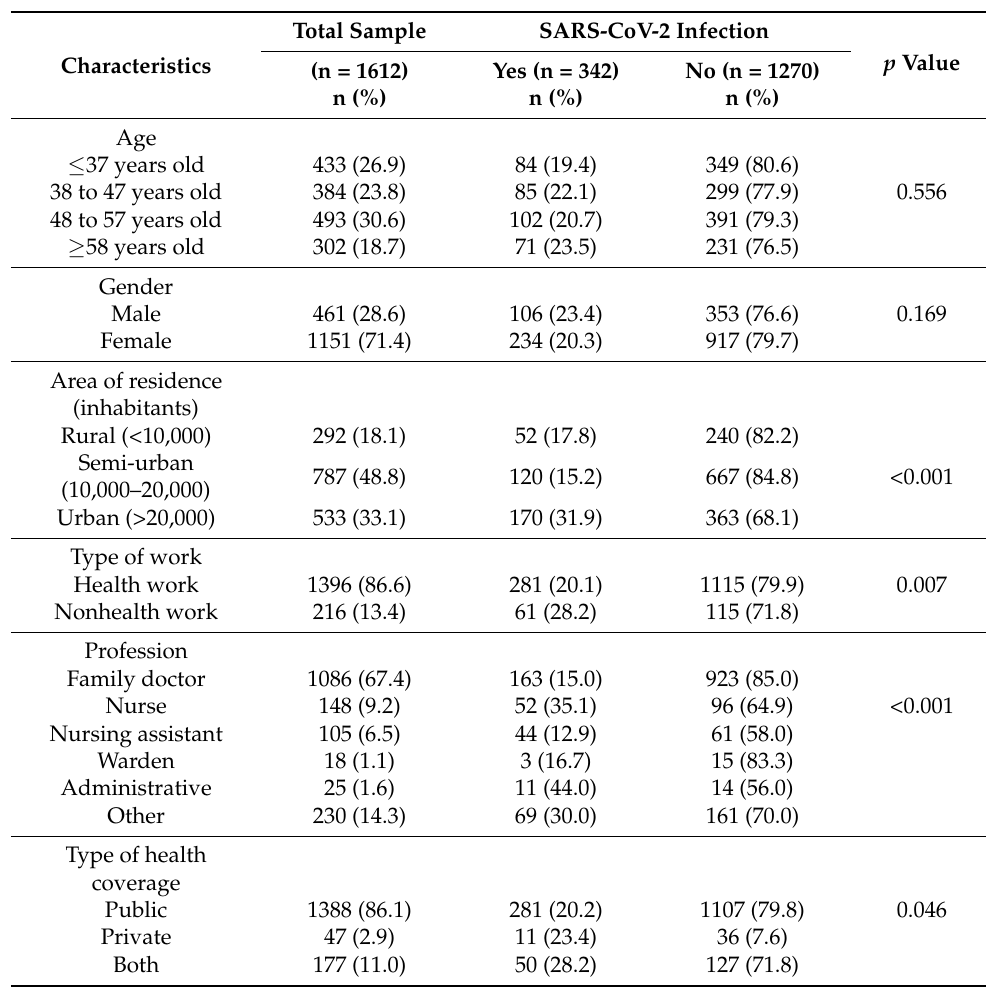
Table 1. Sociodemographic characteristics of the study